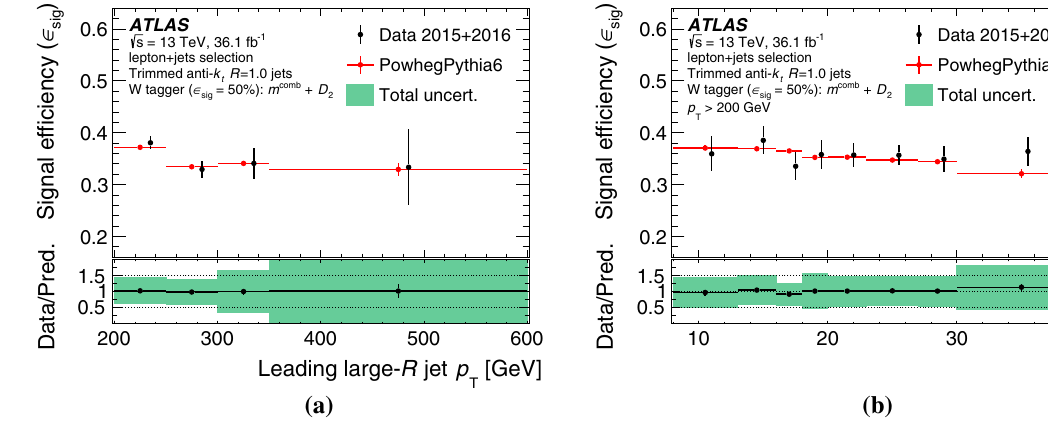
datatothatestimatedinMonteCarlosimulationisshownwithstatistical uncertainties as error bars on the data points and the sum in quadrature of statistical and systematic uncertainties as a shaded band. When con- sidering experimental uncertainties arising from the large- R jet, only those coming from the jet energy scale and resolution are considered